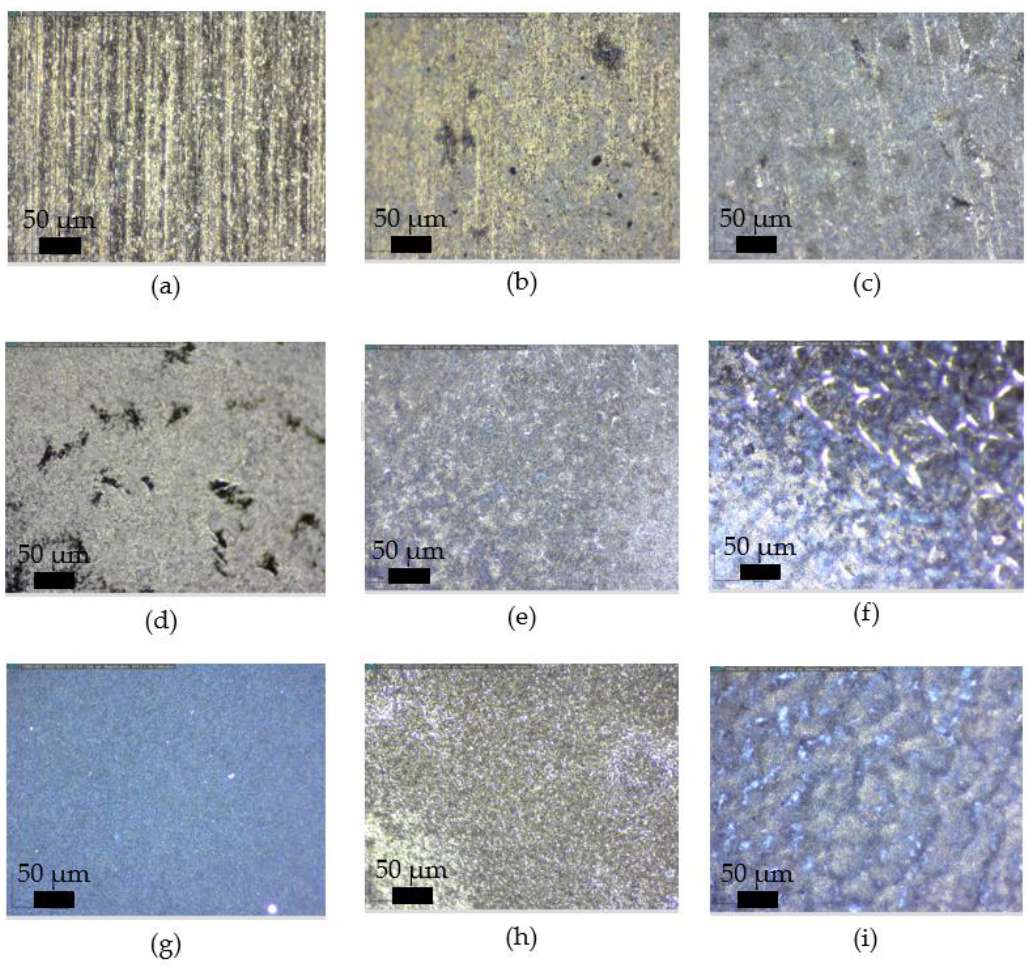
Figure 2. The morphologies of the titanium surface machined at different electropolishing parameters ( a ) 5 V, 0 vol.%, 0 T; ( b ) 5 V, 10 vol.%, 0.41 T; ( c ) 5 V, 20 vol.%, 0.51 T; ( d ) 10 V, 0 vol.%, 0.41 T; ( e ) 10 V, 10 vol.%, 0.51 T; ( f ) 10 V, 20 vol.%, 0 T ( g ) 15 V, 0 vol.%, 0.51 T; ( h ) 15 V, 10 vol.%, 0 T; ( i ) 15 V, 20 vol.%, 0.41 T.